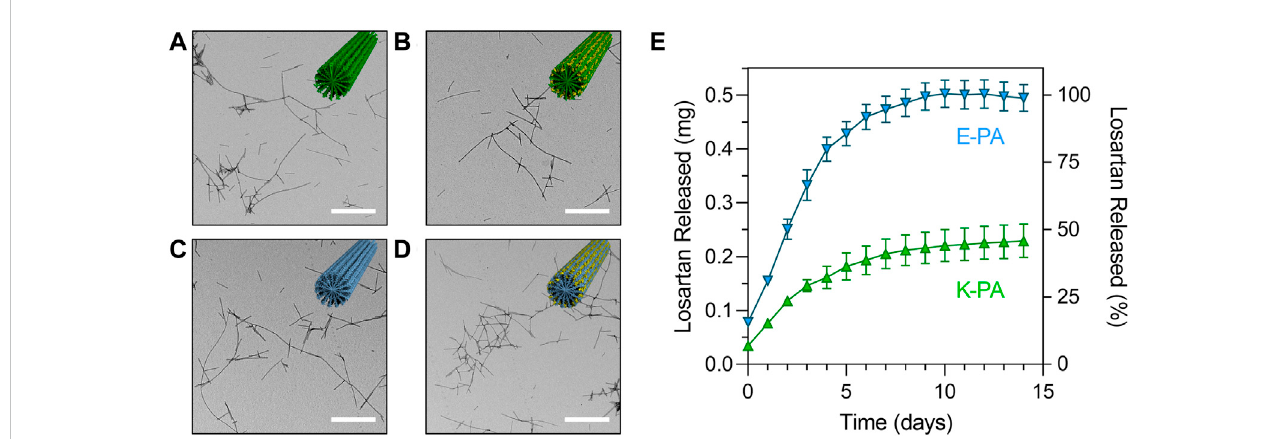
FIGURE 3 Structureandreleasepro fi leoflosartansustainedreleasenano fi bers.Transmissionelectronmicrographsof (A) K-PA fi bers, (B) K-PA fi berswith5 mg/mL losartan, (C) E-PA fi bers,and (D) E-PA fi berswith5 mg/mL losartan.Scalebars=500 nm.Insetsshowillustrationsofnano fi berassemblieswithK-PAingreen, E-PAinlightblue,andlosartaninyellow. (E) Losartanreleasepro fi lefromK-PAandE-PA fi bersforalosartanconcentrationof5 mg/mL,whichcorrespondsto 0.5 mg of total losartan encapsulated in each experiment.